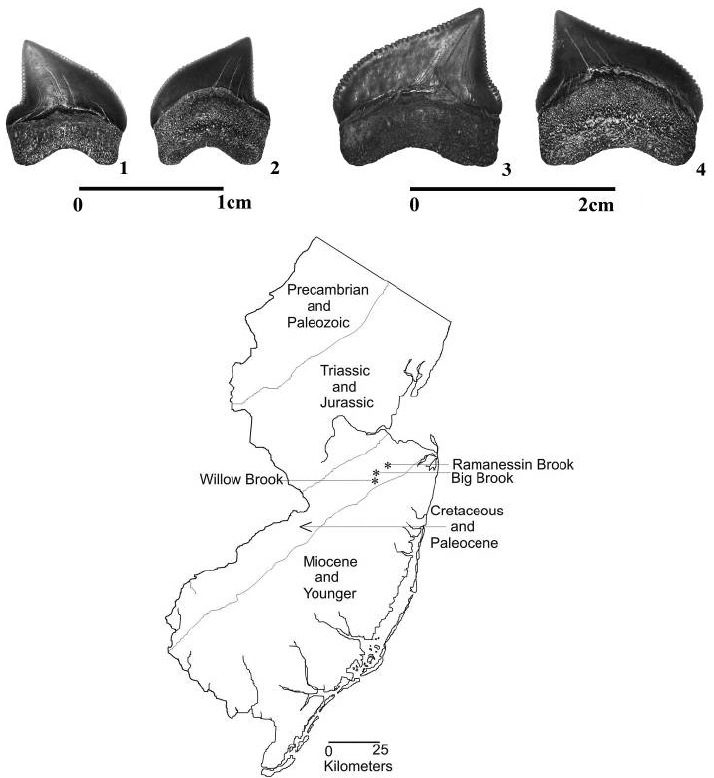
Figure 1. Squalicorax kaupi and Squalicorax pristodontus functional teeth (upper panel) and location of Ramanessin, Big and Willow Brooks, Monmouth County, New Jersey (lower panel). 1 and 2 , Squalicorax kaupi ; 3 and 4 , Squalicorax pristodontus . Differences between Squalicorax kaupi and Squalicorax pristodontus are based on the well-defined distal notch seen in Squalicorax kaupi and the overall larger size of Squalicorax pristodontus . Scale bars: 1,2 = 1.0 cm and 3,4 = 2.0 cm. Tooth orientations: 1,3 = labial face; 2,4 = lingual